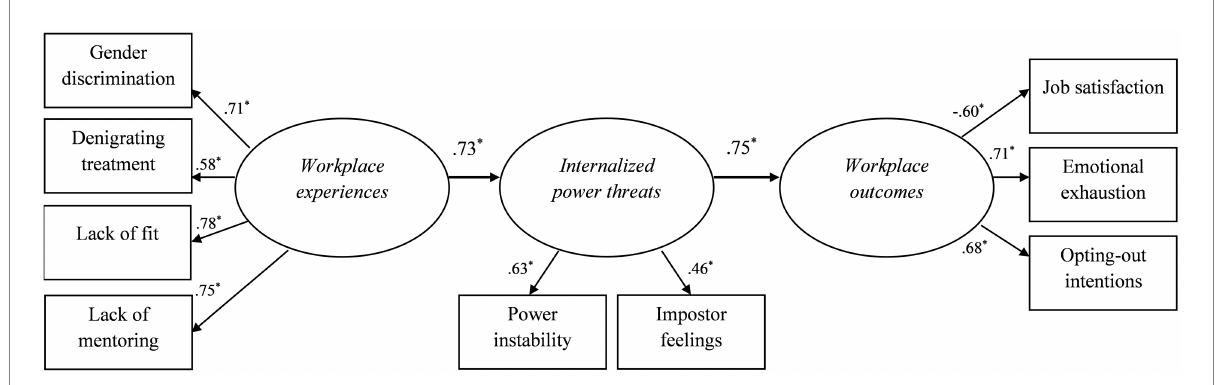
FIGURE 2 Results for hypothesized model. N = 185. * p < 0.05. Standardized regression weights are reported. Model fit: χ 2 [25] = 53.93, p = 0.001, CFI = 0.93, RMSEA = 0.08, TLI =